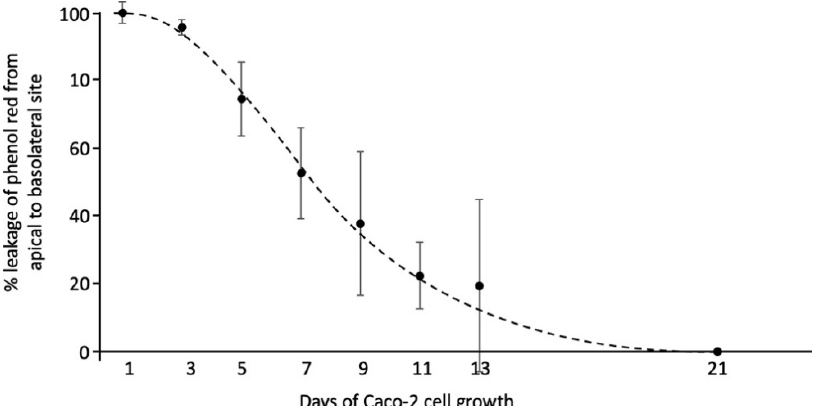
Figure 1. The percentage of phenol red leakage from the apical to the basolateral compartment in the transwell system. Medium solution (MEM) with phenol red was added to the apical compartment, while MEM without phenol red was added to the basolateral compartment. The optical density (OD) of the medium solution in both compartments was measured across the different days of Caco-2 cell growth. All results are presented as the mean, while error bars indicate standard deviations.